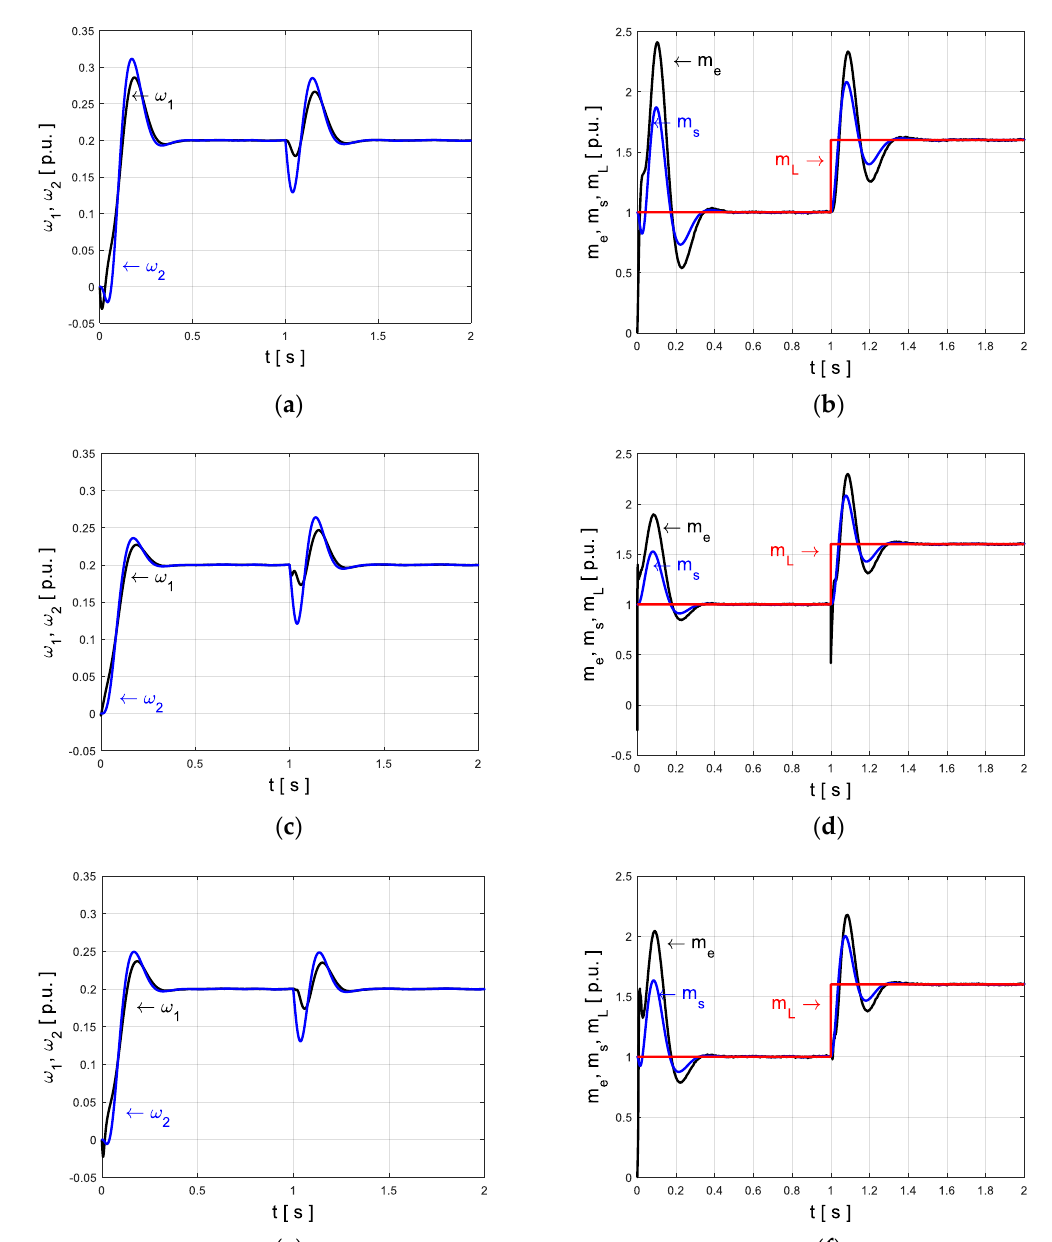
Figure 7. Transients of the system states: driving motor and load machine speeds ( a , c , e ), driving (electromagnetic), shaft and load (disturbance) torques ( b , d , f ), for the closed-loop system working with single observer ( a , b ) and multilayer observer – version 1 ( c , d ) and version 2 ( e , f ) – simulation.